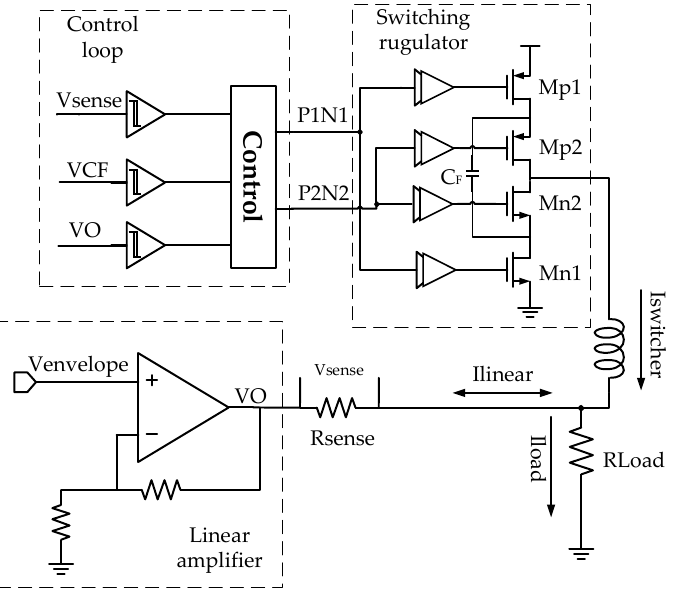
Figure 2. Block diagram for proposed ET modulator.